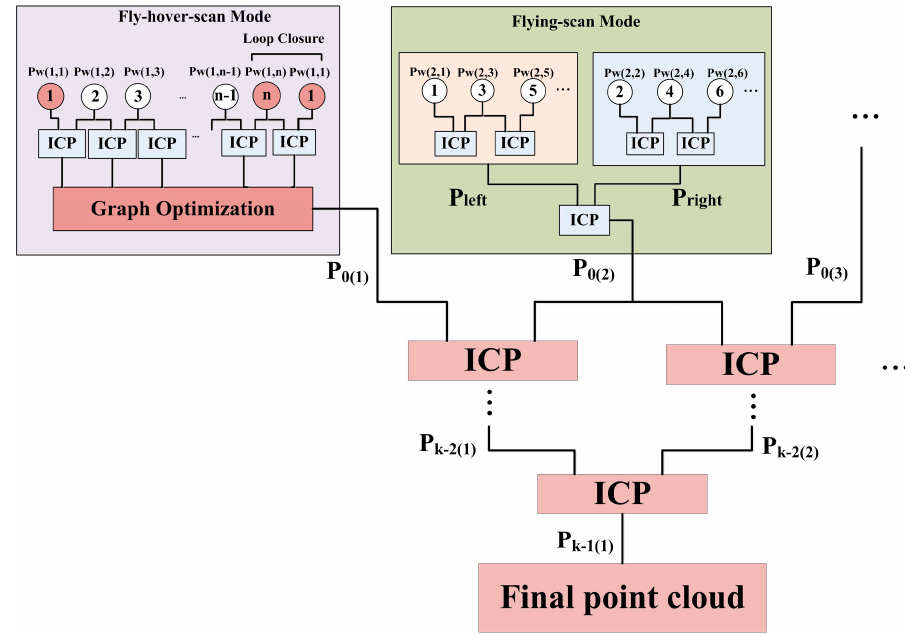
Figure 3. Hierarchical optimization framework.